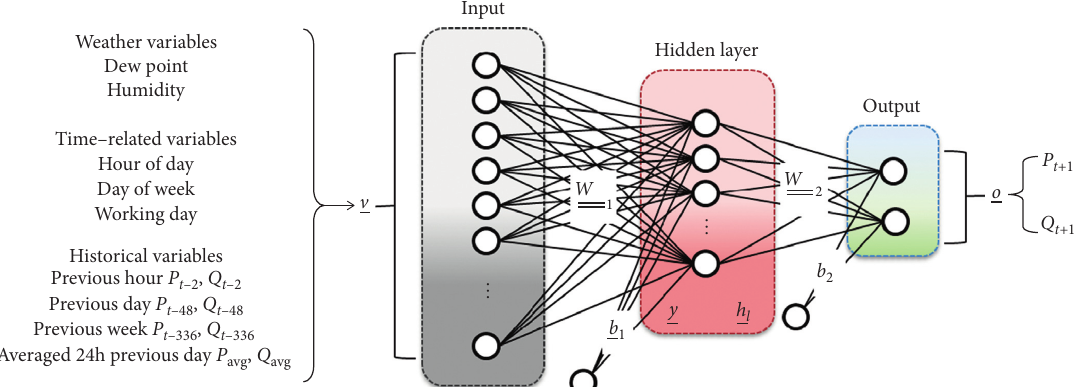
Figure 1: Structure of the active ( P ) and reactive ( Q ) power one-step ahead forecasting neural network model for SMEs (the structure of the neural network for residential loads considers only active power both in the input and the output